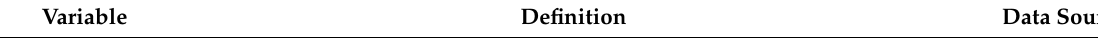
Table A1. Descriptions of